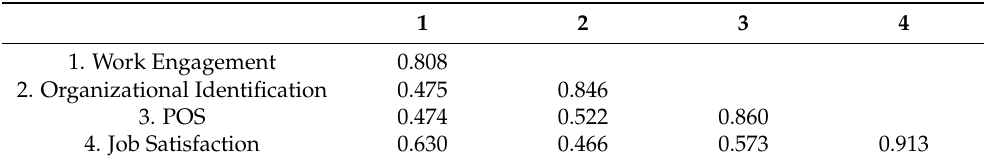
Table 3. Correlations and descriptive validity of model